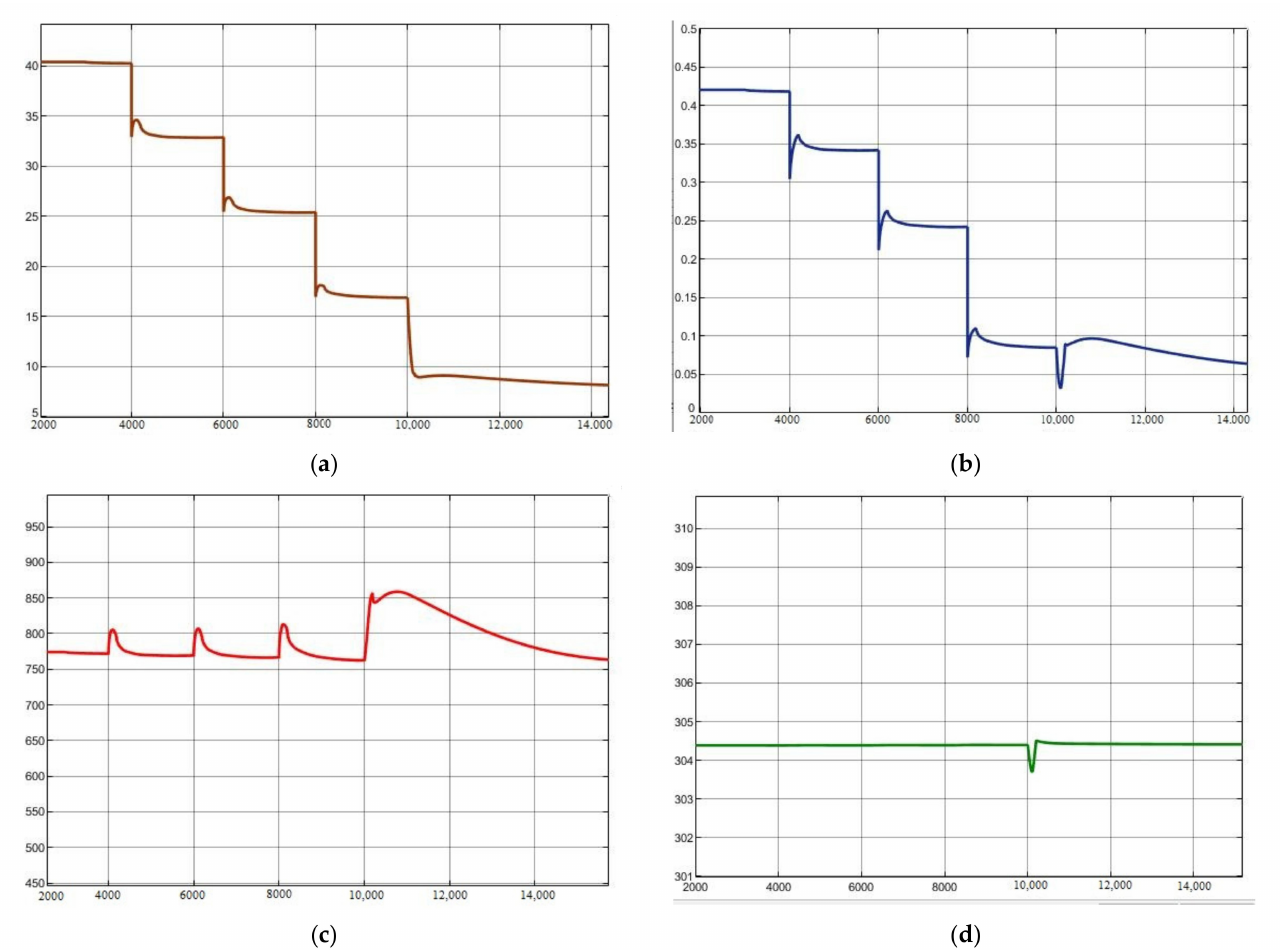
Figure 12. The system dynamic characteristics of the load-decreasing process. ( a ) Turbine output power. ( b ) circle efficiency. ( c ) Turbine inlet temperature. ( d ) Main Compressor inlet